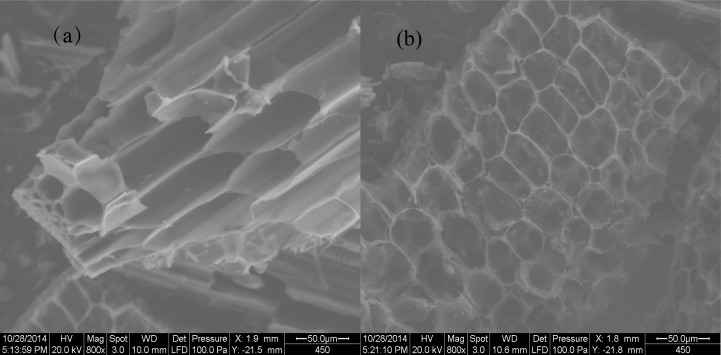
Scanning electron microscope (SEM) images of maize biochar produced at 450°C (a, b). (a) denotes the cross section of biochar, (b) denotes longitudinal section of biochar.